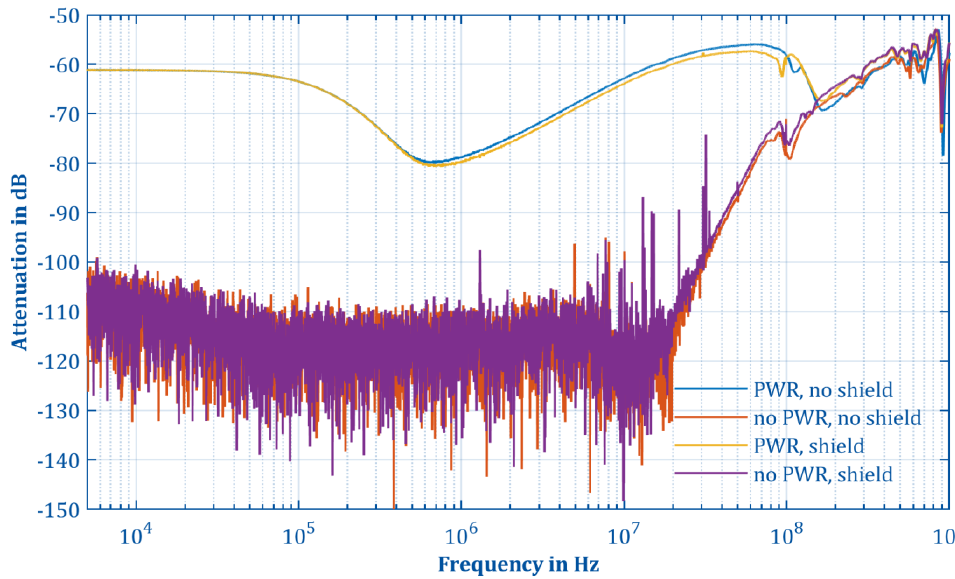
Figure 12. Transmission response with activated and deactivated power supply with and without additional electrical shielding by a grounded copper foil wrapped around the buffer stage.